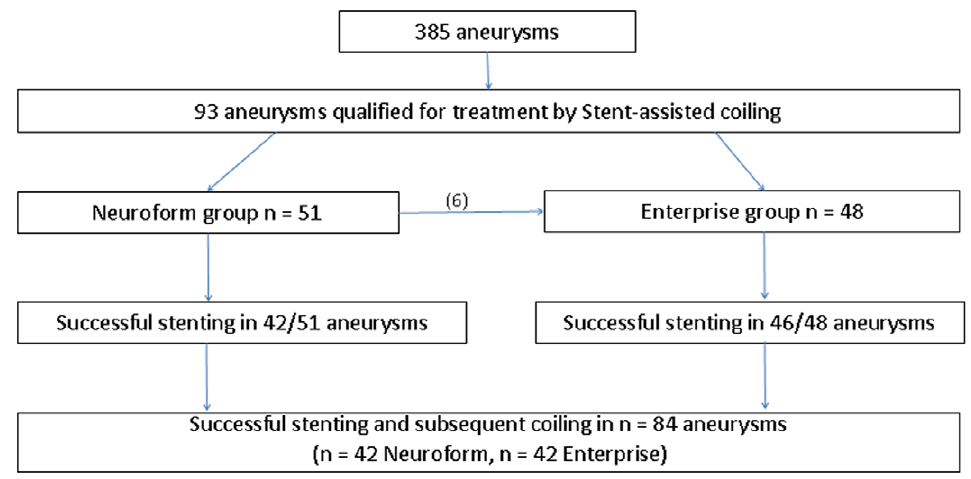
Figure 1. Flow chart of aneurysms treated by stent-assisted coiling.